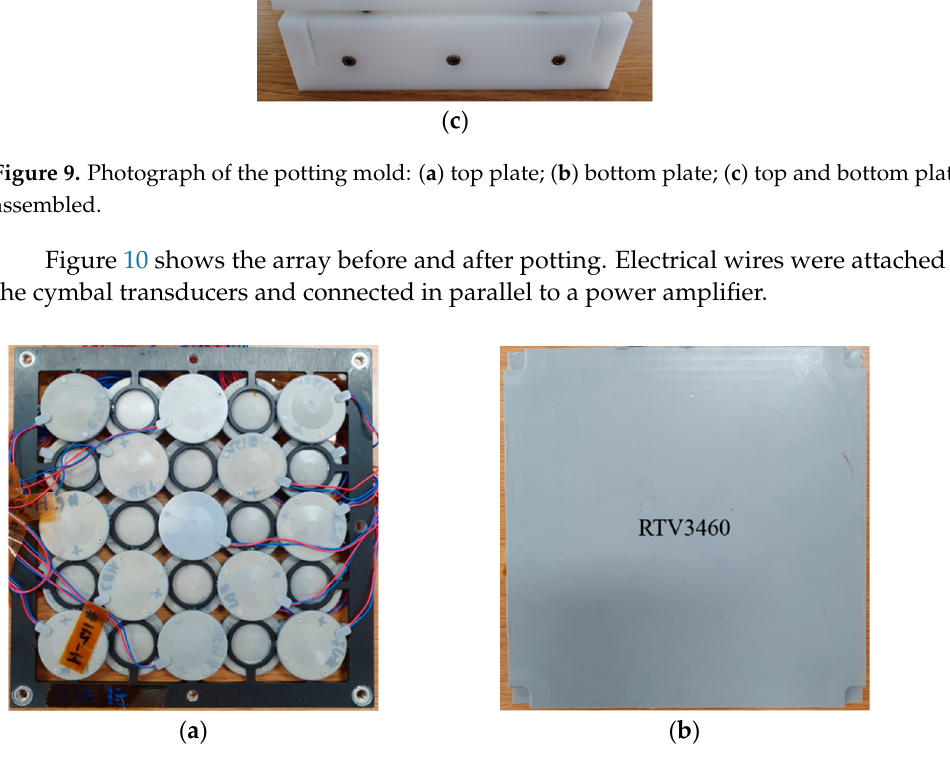
Figure 11. Experimental setup for underwater TVR spectrum measurement. 1 2 3110120130140150 Normalized Frequency ( × f o ) T V R ( d B r e 1 (cid:1) P a / V @ 1 m ) measured FEA Figure 12. TVR spectra of the potted array.